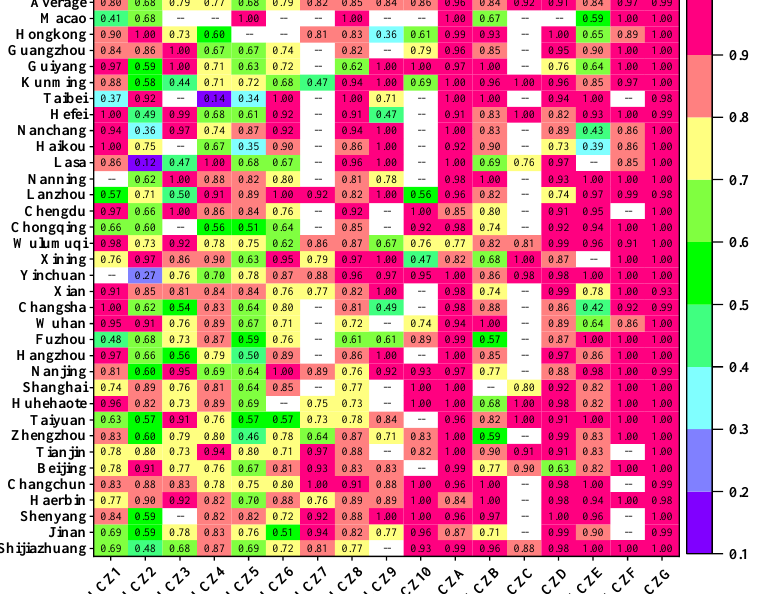
Figure 6. The accuracy of each LCZ type for the 34 cities and the average accuracy is given at the top line for all cities. Dashed lines indicate no accuracy score.